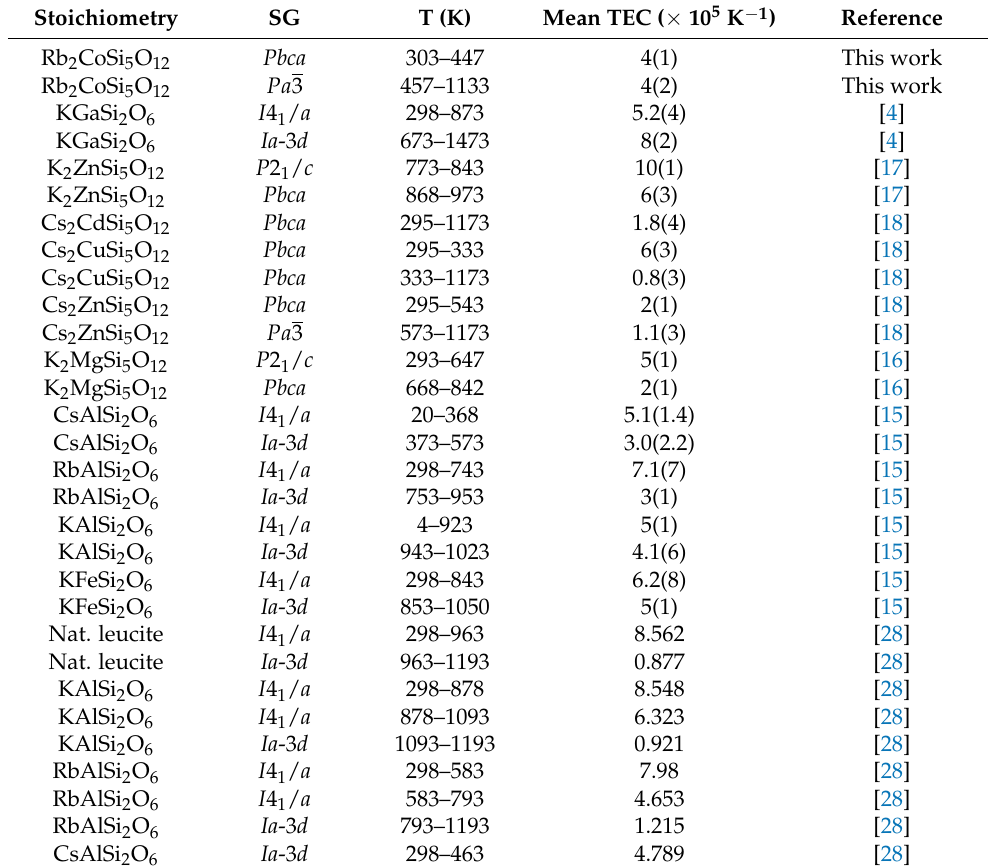
Table 8. Thermal expansion coefficients (TEC) for leucite